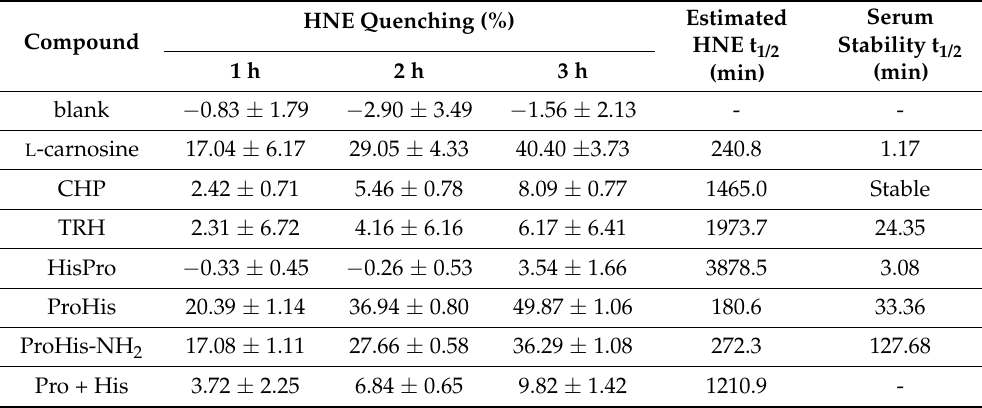
Table 2. HNE quenching activity (as percentages of quenched HNE at different times) and serum stability of the studied peptides. Estimated HNE half-lives are also reported. For easy comparison, the corresponding values for L -carnosine are also included.